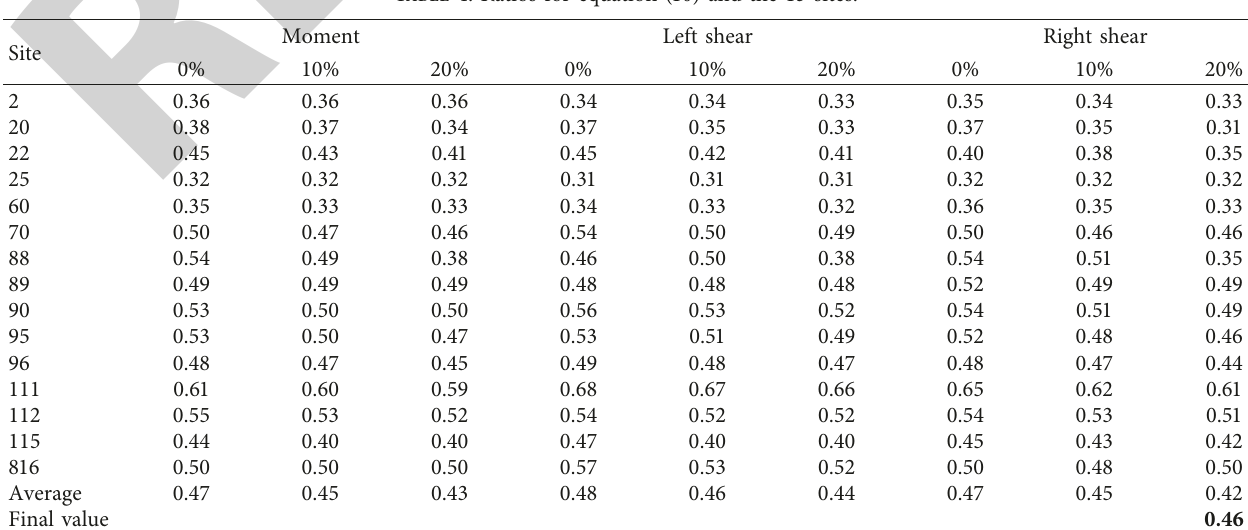
Table 4: Ratios for equation (10) and the 15